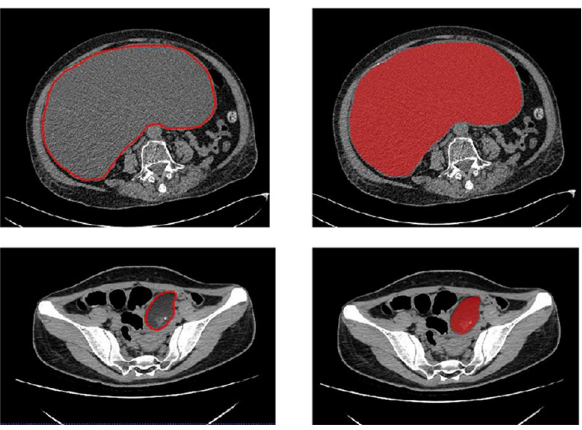
Figure 1. Manual delineation on the slice having the largest ovarian lesion